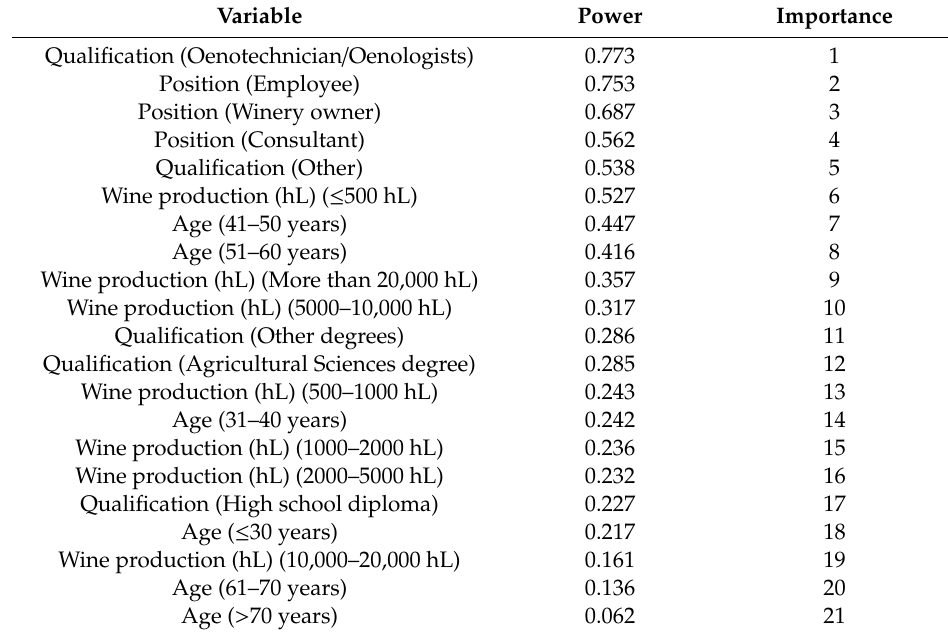
Table 6. Variable importance obtained by the principal component